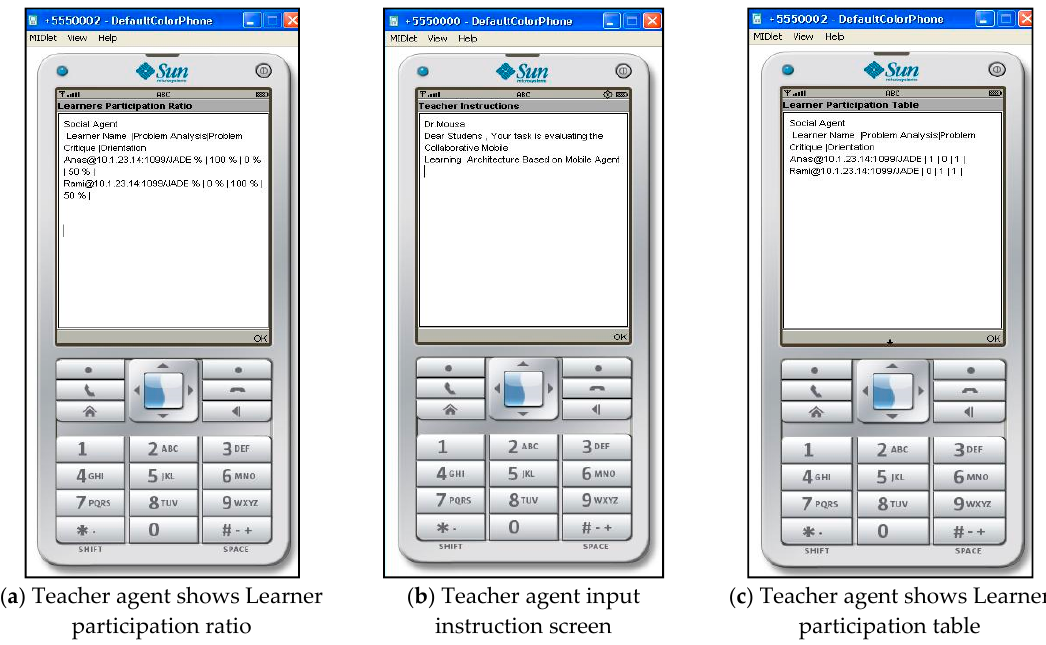
Figure 16. Mobile learning GUI — teacher agent on mobile device.